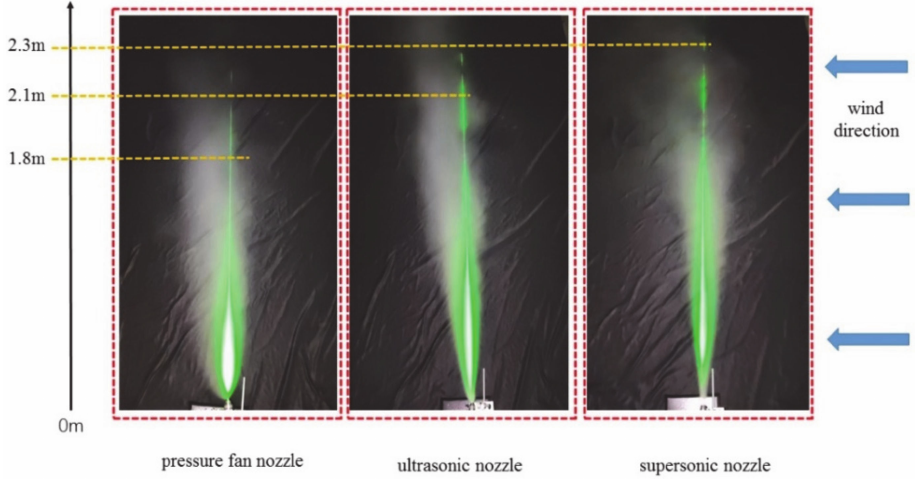
Figure 10. Spray state of different nozzles under the influence of lateral